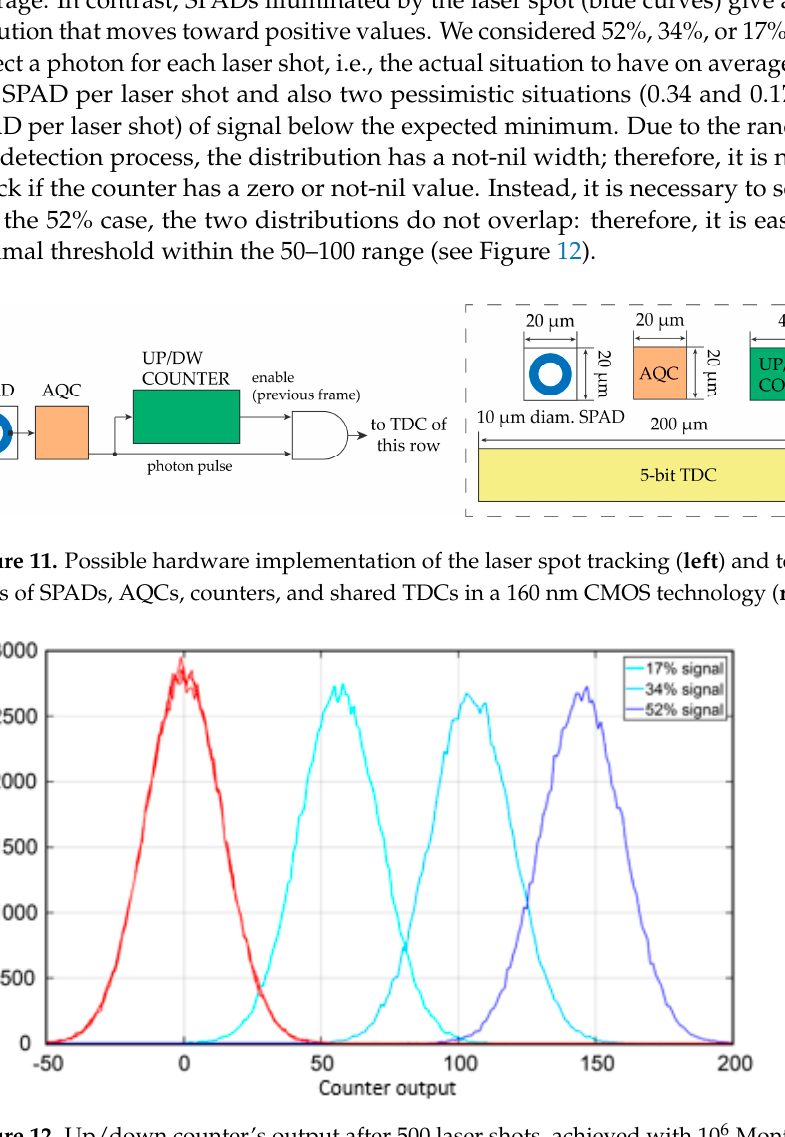
Figure 10. Timing diagram of the signals to properly count ( upwards ) signal and background pho- tons and to subtract ( downwards ) only background photons, during one frame (i.e., 500 laser pulses). Two SPADs are considered, SPAD #1 inside and SPAD #2 outside the laser spot, thus ac- cumulating a total positive count and an average nil count, respectively.